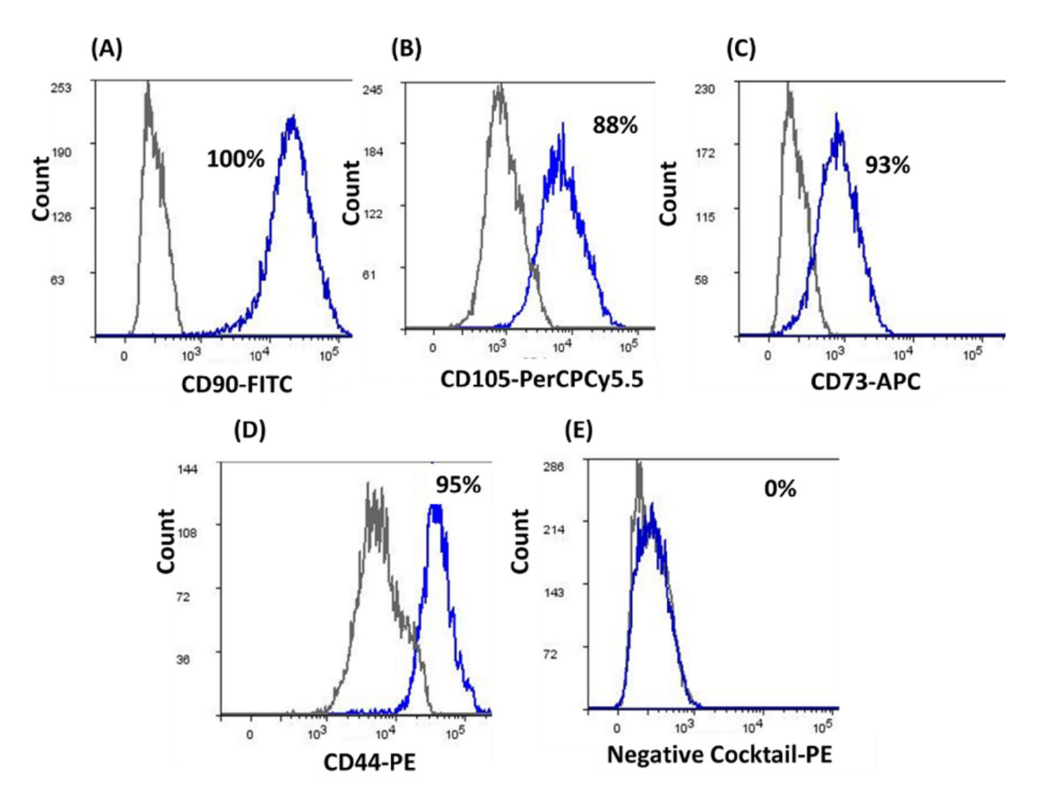
Figure 2. Flow cytometric analysis of mesenchymal stem cells (MSC) surface markers expression of DPSCs derived from pulp tissue. DPSC histograms show that cells are positive for MSCs surface markers ( A ) CD90, ( B ) CD105, ( C ) CD73, and ( D ) CD44, and ( E ) have negative expression of hematopoietic stem cells surface markers (negative cocktail), including CD45, CD34, CD19, CD14 and